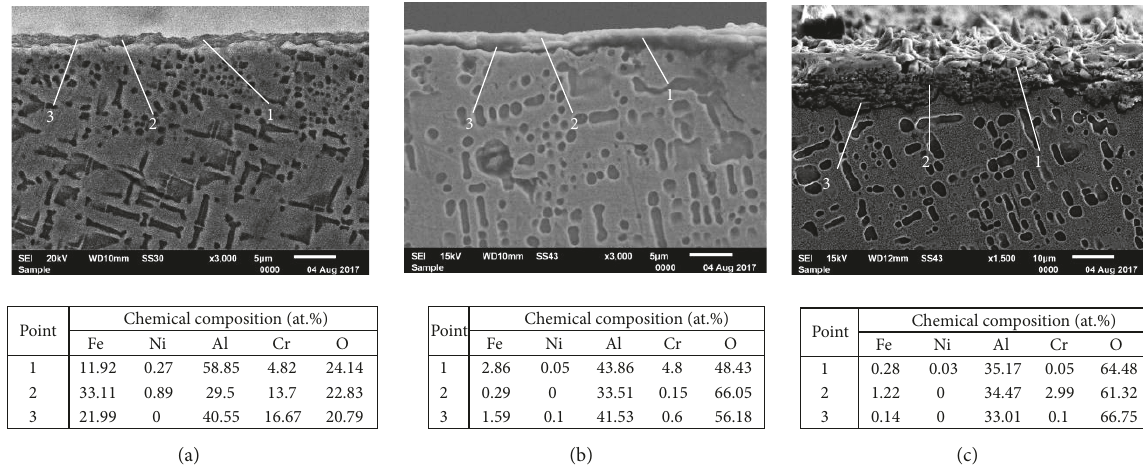
Figure 6: Scale formed on the samples exposed within 150 hrs. at (a) 800 ∘ C, (b) 900 ∘ C, and (c) 1000 ∘ C.